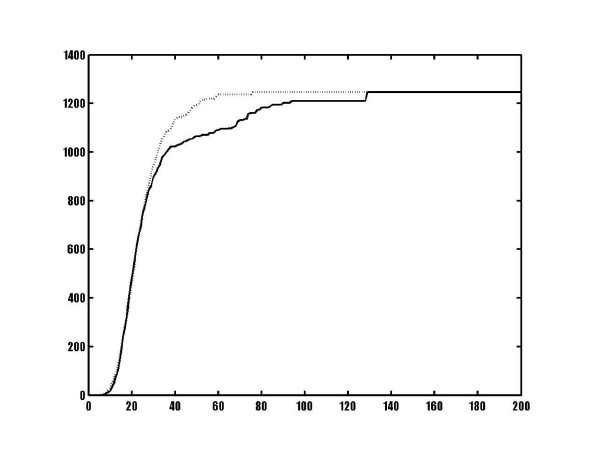
Cumulative histograms. Cumulative histograms for the data in Figures 1 and 2: solid line: original data from Figure 1, dotted line: randomised data from Figure 2. The X axis shows the size of lists of similar words, the Y axis is the number of lists.